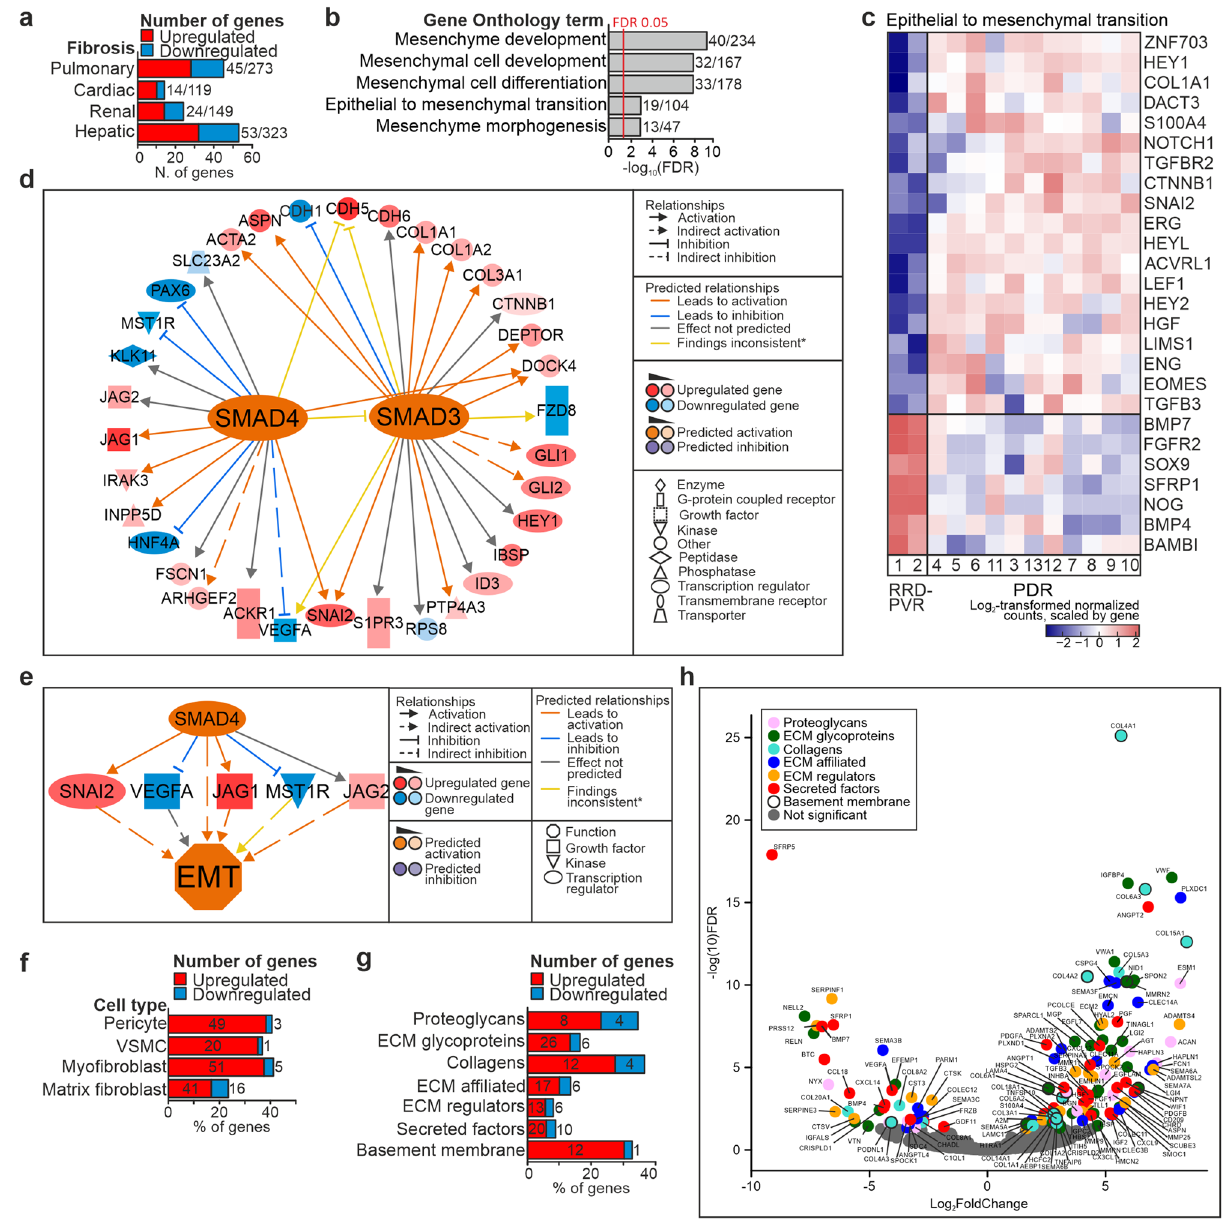
Figure 7. Epithelial to mesenchymal transition and the extracellular matrix changes are involved in PDR and RRD-PVR. ( a ) Stacked bar chart summarizing the number of DEGs (upregulated, red; downregulated, azure) among the pulmonary, cardiac, renal and hepatic fibrosis signature genes 24 . Numbers beside bars indicate number of DEGs in the signature versus the total number of genes in the signature. ( b ) Bar chart showing GO-terms related to epithelial to mesenchymal transition (EMT) and mesenchyme development, significantly enriched based on DEGs upregulated in PDR. Numbers beside bars indicate the number of significant genes in GO-term versus the total number of genes in GO-term. ( c ) Heatmap of log 2 -transformed normalized read counts of DEGs in the GO-term Epithelial to mesenchymal transition . ( d ) The function of SMAD3 and SMAD4 was predicted to be activated. ( e ) SMAD4 was found within the regulator effect network with targets SNAI2, VEGFA, JAG1, JAG2 and MST1R, and the activated effect Epithelial-mesenchymal transition (EMT). (*) Yellow arrows indicate findings inconsistent with the state of downstream molecule. ( f ) Stacked bar chart summarizing the percentage of DEGs (upregulated, red; downregulated, azure) among “vascular smooth muscle cell”, “pericyte”, “myofibroblast” and “matrix fibroblast” cell signature genes 28 . Numbers in brackets beside bars indicate the total number of genes in each signature ( g ) Stacked bar charts summarizing the percentage of DEGs among the matrisome signature genes 30 . ( h ) Volcano plot depicting the differential expression of matrisome genes 30 . DEGs are color-coded as indicated, number of genes indicated in or adjacent to bars. The networks in ( d ) and ( e ) were generated through the use of IPA (QIAGEN Inc., https:// www. qiage nbioi nform atics. com/ produ cts/ ingen uity- pathw ay- analy sis) 45